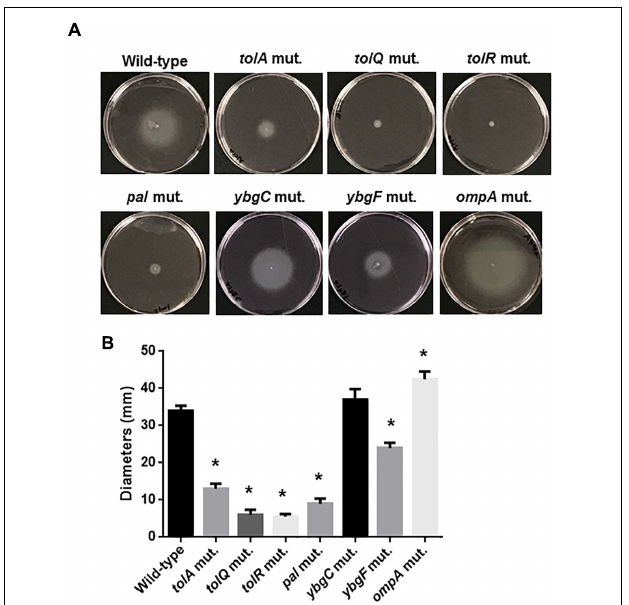
FIGURE 8 | Motilities of the wild-type parent, and the tol - pal and ybgC , ybgF , and ompA mutants. (A) Bacterial migrations on RPMI1640 medium containing 0.3% agar after 10 h at 37 ◦ C under 5% of CO 2 were pictured. (B) Bacterial migrations on the agar were represented as diameters. Data plotted are the means from three independent experiments; error bars indicate the standard deviations ∗ P < 0.01. Asterisks denote significance for values relative to the wild-type control.